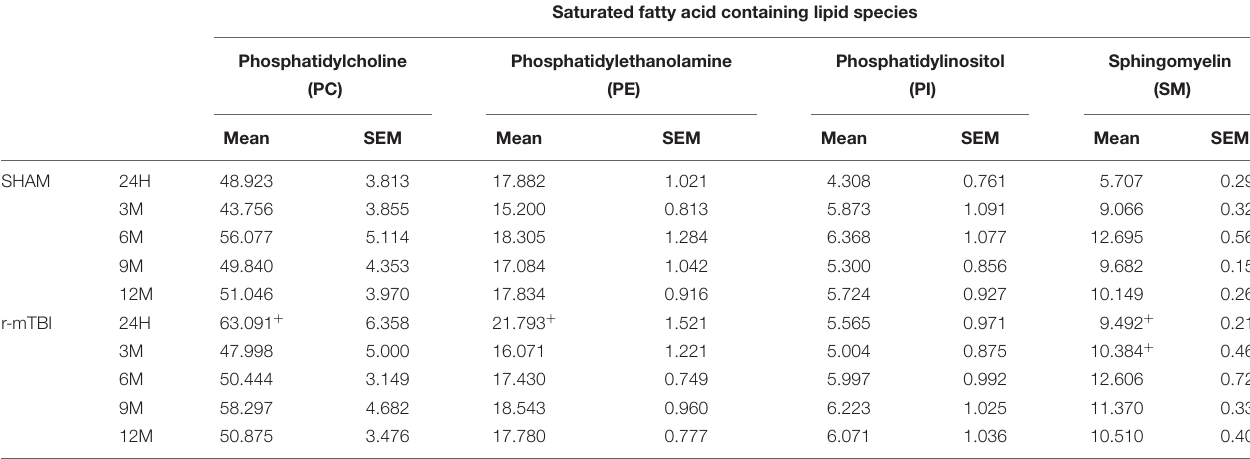
TABLE 6 | Saturated fatty acid containing phospholipid species in the cortex of repetitive mTBI hTau